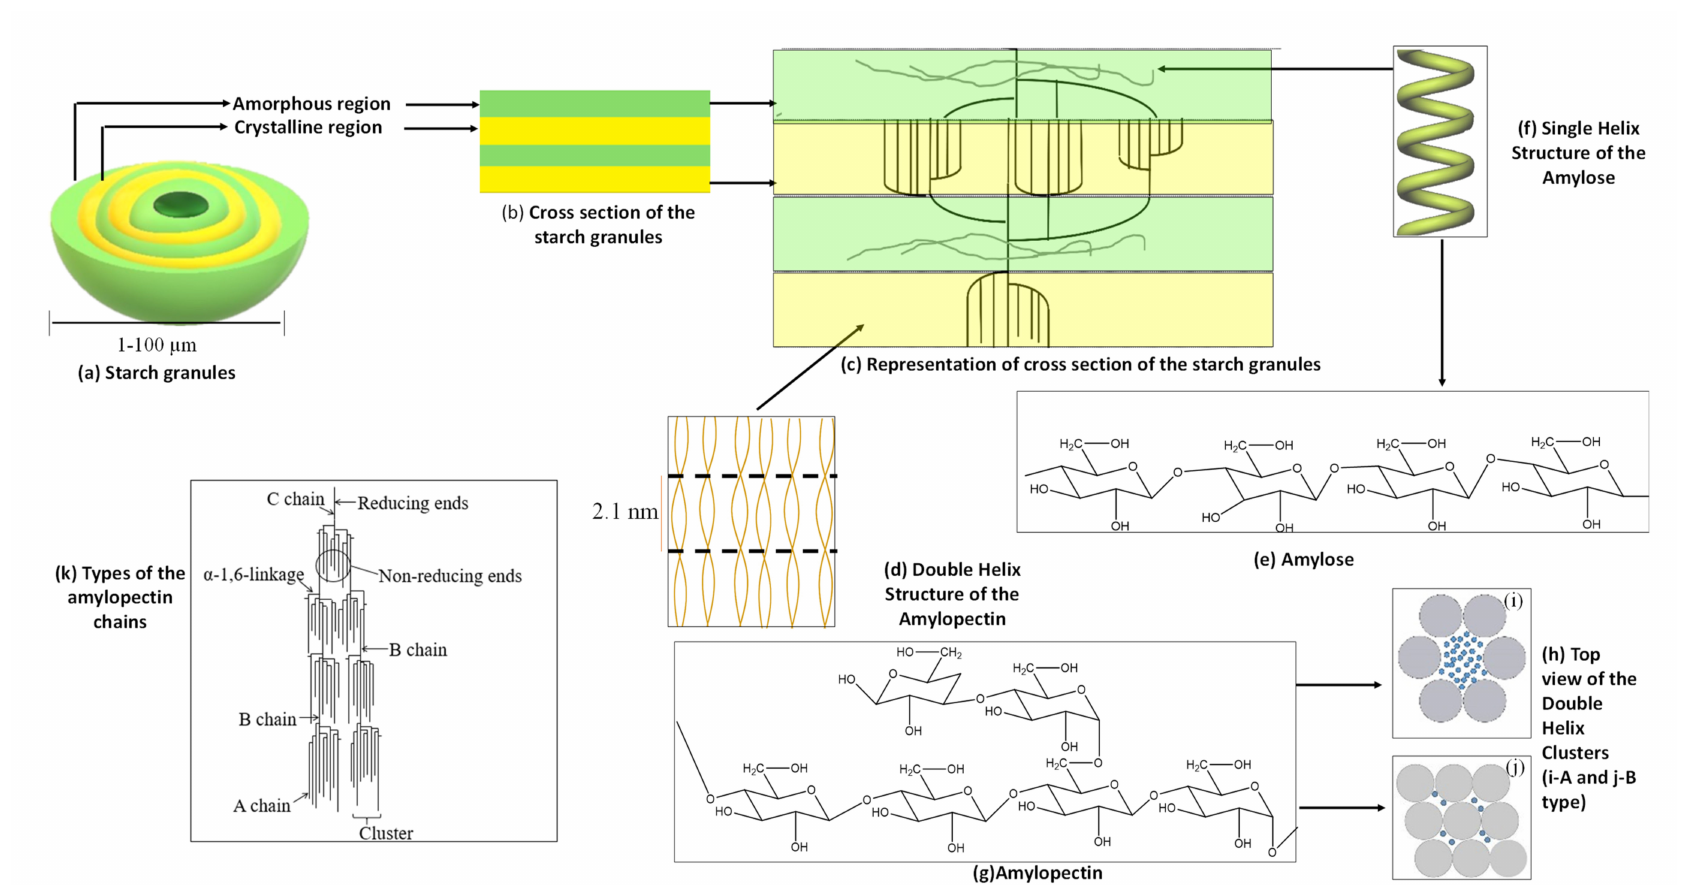
Figure 2. Schematic representation of the ( a ) Starch granules; ( b ) Cross section of the starch granule; ( c ) Representation of the cross section of the starch granules; ( d ) Double helix structure of amylopectin; ( e ) Structure of amylose; ( f ) Single helix structure of amylose; ( g ) Structure of amylopectin; ( h ) Top view of the double helix clusters: ( i ) A type, ( j ) B type, and ( k ) Types of amylopectin